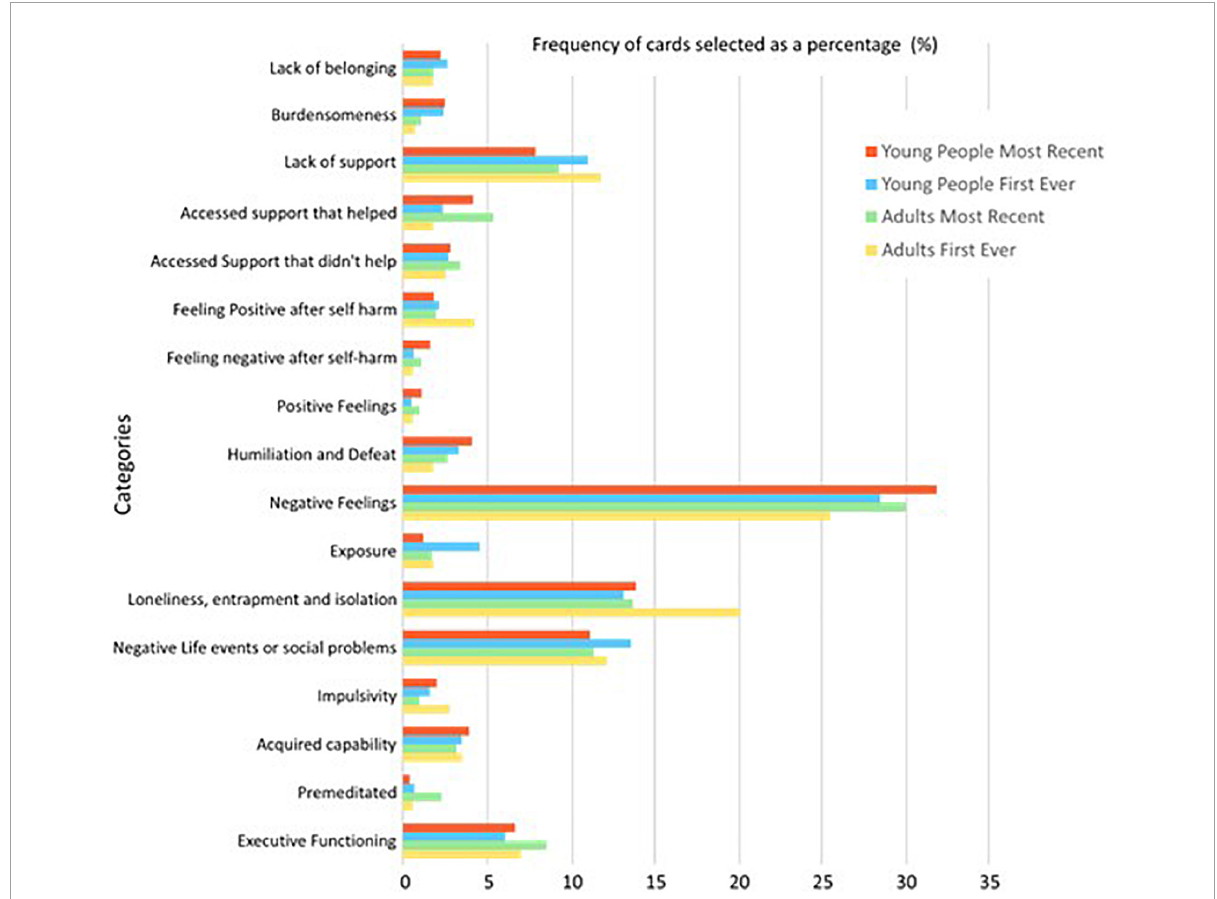
FIGURE2 A graph displaying the frequency of cards, pooled as a percentage of cards in each category, across each of the four groups.